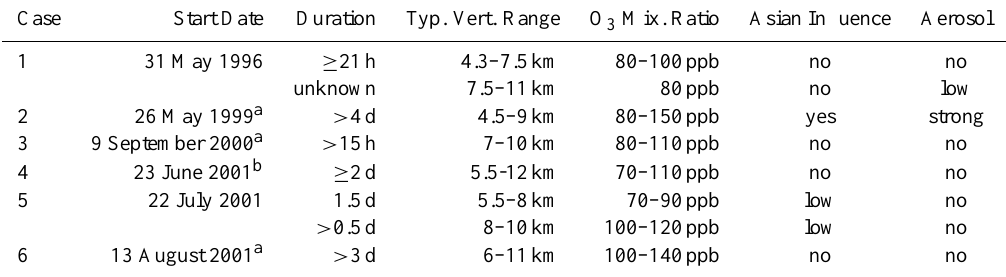
Table 1. Overview of the high-ozone layers analysed.